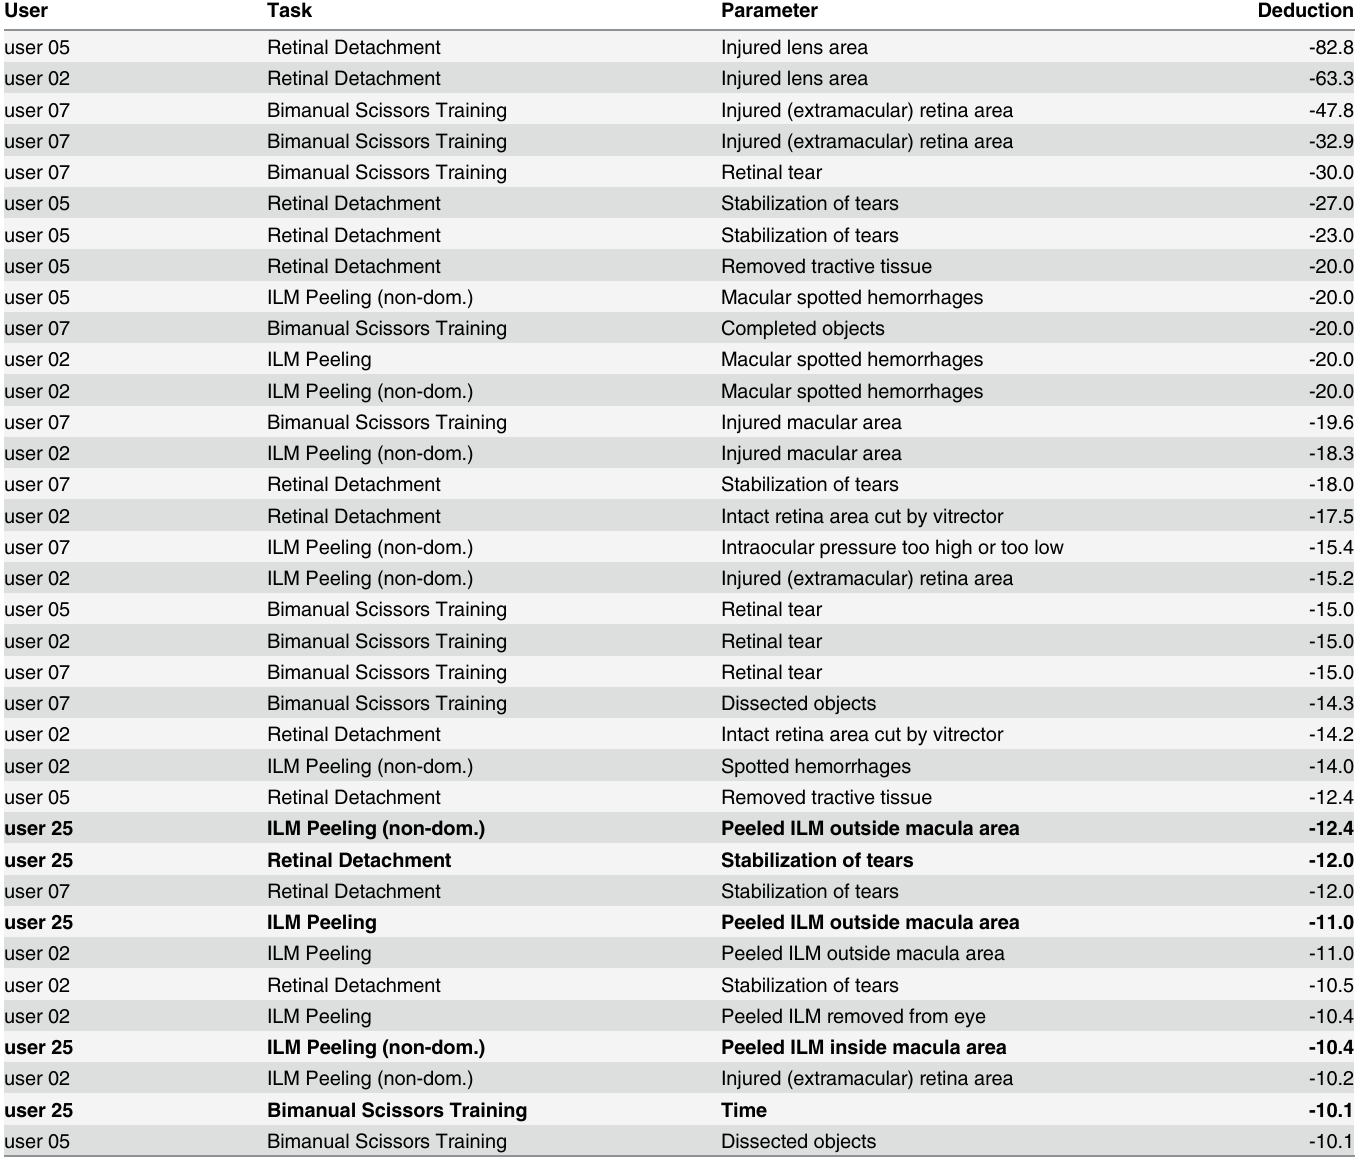
For the expert “ user 25 ” (rows marked in boldface), fewer points are deducted and the losses are focused on target criteria, whereas all other users get the most deductions for